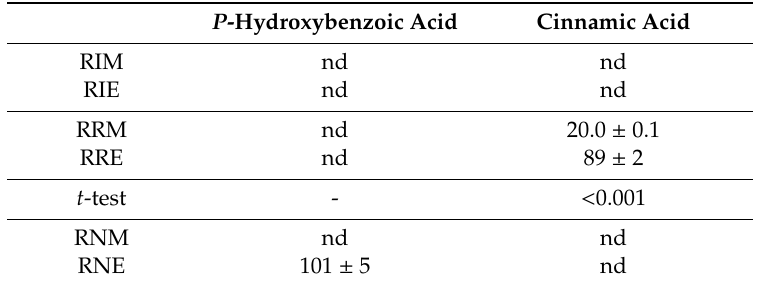
Table 3. Phenolic and cinnamic acids composition of the studied mushroom extracts ( µ g / g of extract) (mean ± SD, n =